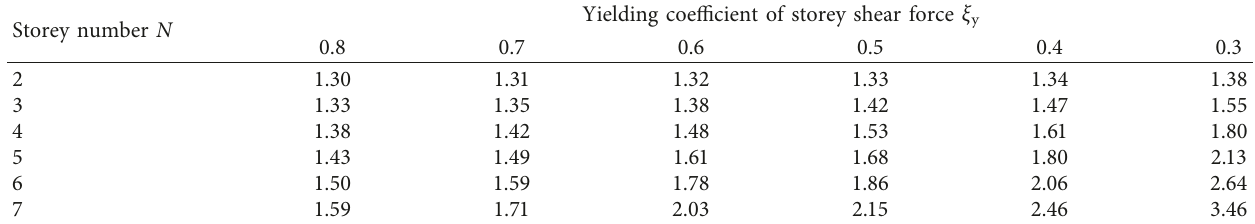
) suggested by Comparisons of different DFs (or η p equations (15)–(18) with various ductility demands are depicted in Figure 19. It is clear that the deflection amplifi- cation factor increases gradually with the increase in structural ductility. However, the influence rule of structural period is still uncertain, and different studies show different results.